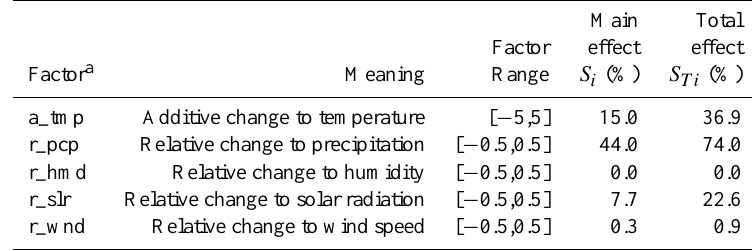
Table 1. Sensitivity indices of the five meteorological variables based on the Sobol’ method.